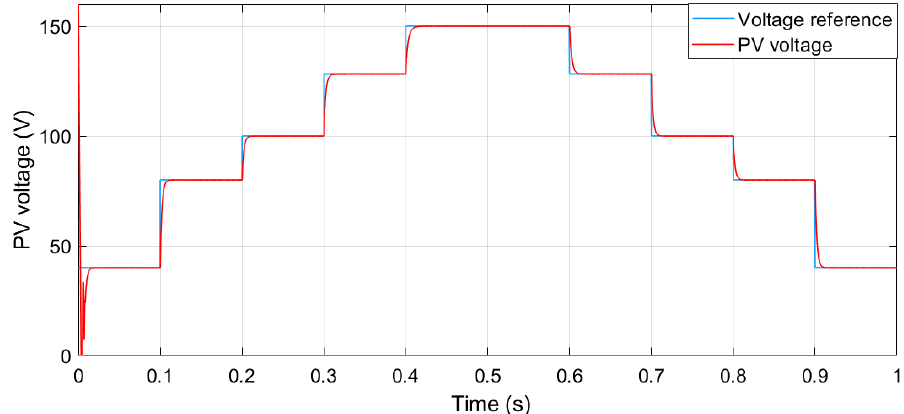
Figure 10. PV voltage.